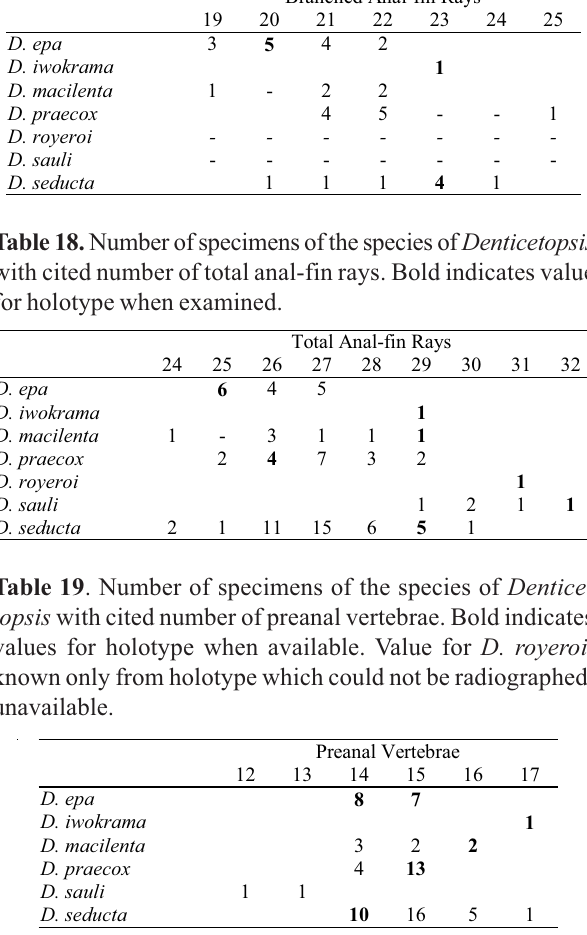
Table 21. Number of specimens of the species of Denticetopsis with cited number of caudal vertebrae. Bold indicates value for holotype when available for this study. Value for D. royeroi , known only from holotype which could not be radio- graphed, unavailable.